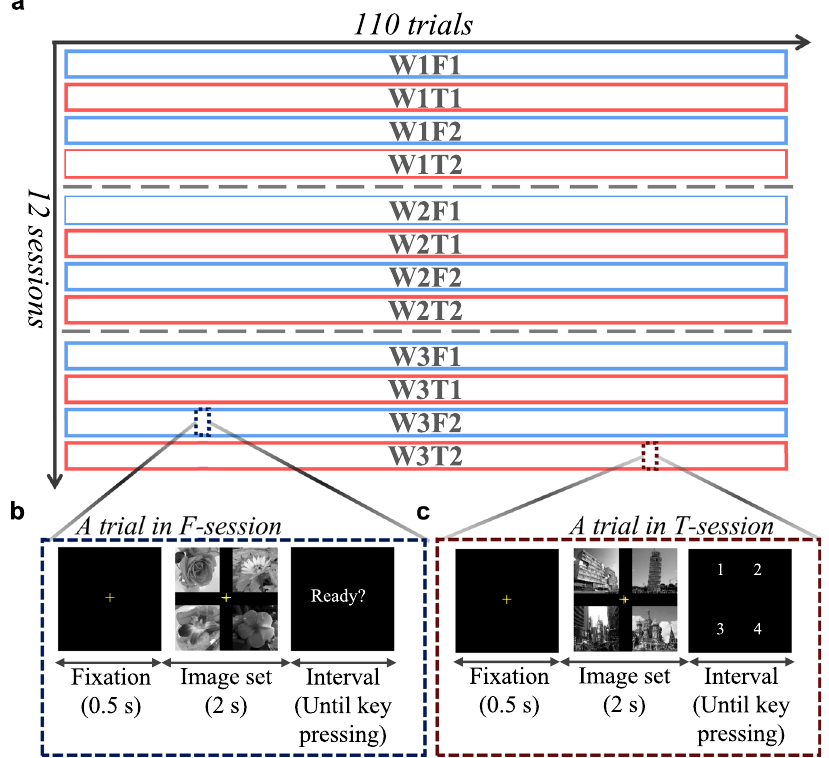
Figure 1. Overall procedure of the experiment. ( a ) Organization of Free and Task sessions for each subject. Sessions were named according to the week of recording and the type of session. The same 110 image sets were presented in a different order in each session. ( b ) A trial in a Free session. An image set was presented in a trial. A subject observed each image set with no task in Free sessions. ( c ) A trial in a Task session. After observing an image set, a subject had to choose their favourite